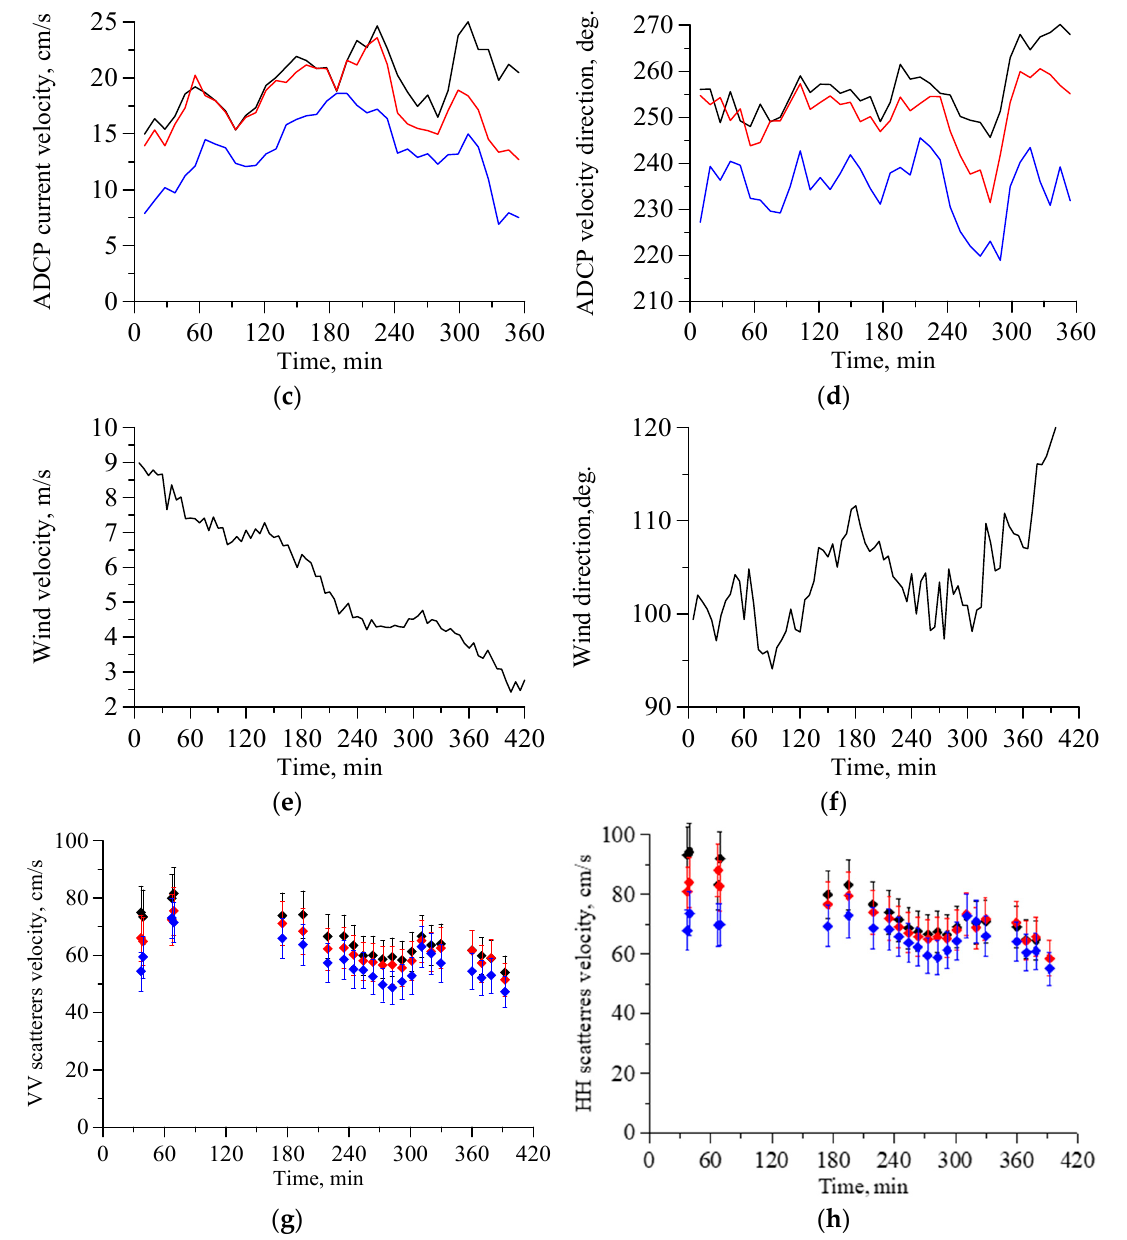
Figure 2. Case study 4.1. ( a ) Schematic representation. ( b ) The ADCP current velocity profiles in the beginning (black), middle (red), and end (blue) of the case study. ( c ) The ADCP current velocity and ( d ) direction at depths of 1 m (black curve), 4 m (red curve), and 10 m (blue curve). ( e ) The wind velocity and ( f ) direction. ( g ) The scatterer’ velocities at VV and ( h ) HH polarizations. Black symbols correspond to S-band, red—C-band, blue—X-band.